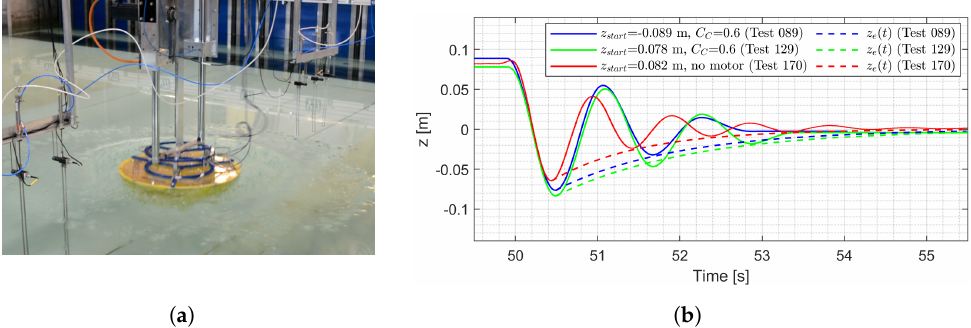
Figure 16. Free decay tests: ( a ) Picture of Test_161; ( b ) z time series of the free decay tests and corresponding exponential decay envelopes (Test_089, Test_129 and Test_170).